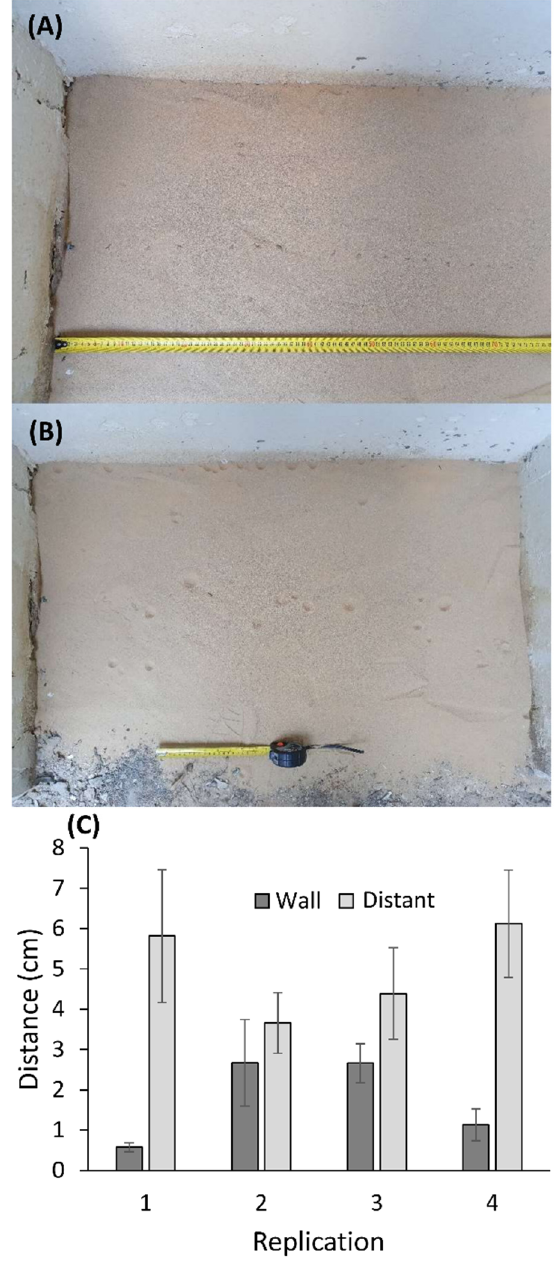
Figure 6. The experiment examining wormlion relocation as a function of the distance from the wall, ( A ) immediately after placing the wormlion, and ( B ) 24 h later. ( C ) The distance moved depending on the initial position, presented separately per replicate. Means ± 1 SE are presented.